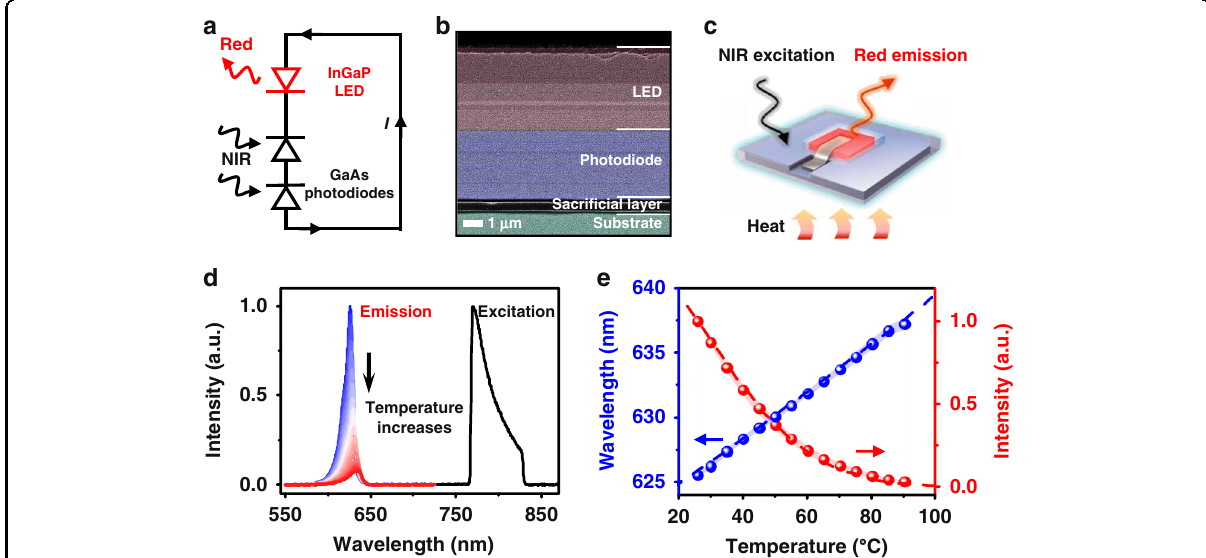
Fig. 1 An optoelectronic upconversion device with temperature dependent light emission. a Circuit diagram and ( b ) Scanning electron microscopic (SEM) image of the optoelectronic upconversion design, including an InGaP red LED and a GaAs double junction photodiode with serial connection. c Schematic diagram of the upconversion device for temperature sensing. d Spectra of the excitation and the upconverted photoluminescence (PL) emission at varied temperatures (25 – 90 °C). e Calculated (dash line) and measured (dots) peak wavelength and PL intensity of the upconverted red emission as a function of temperature, and the shaded range represents the standard deviation measured among 10